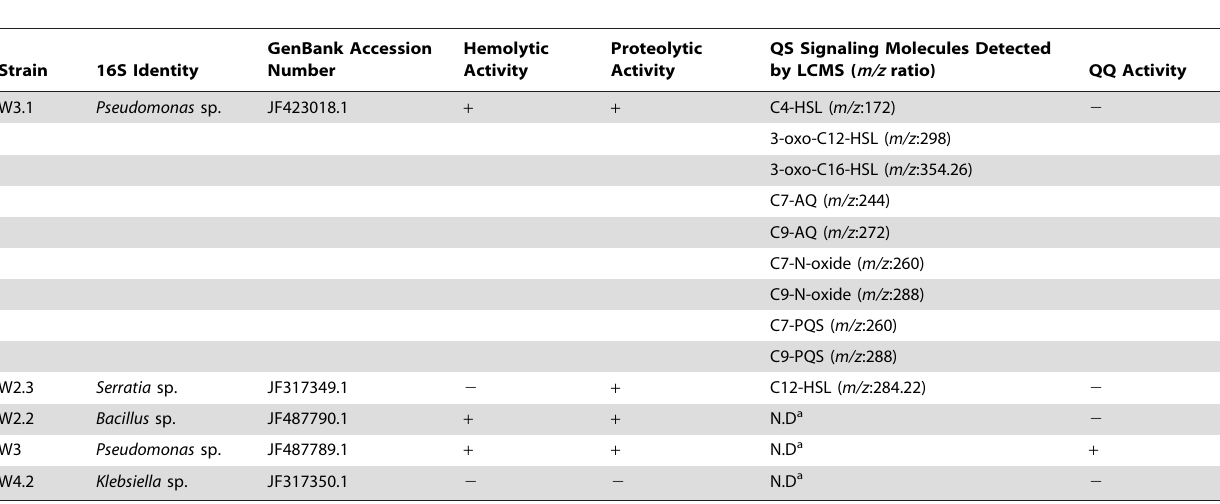
Table 2. Summary of phenotypic properties of isolated bacterial strains from infected tilapia.